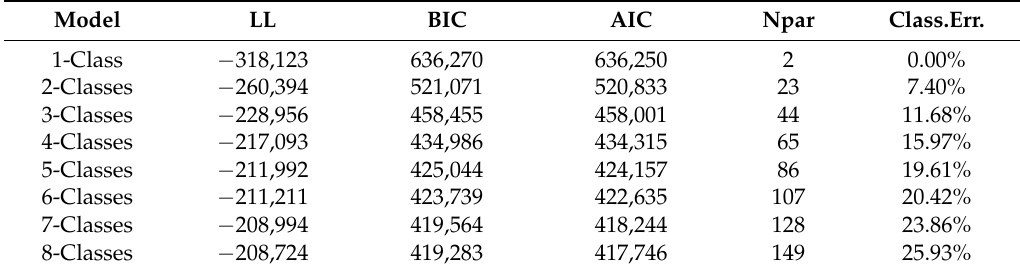
Table A1. Goodness of fit for profile latent models. From 1 to 8 classes or clusters